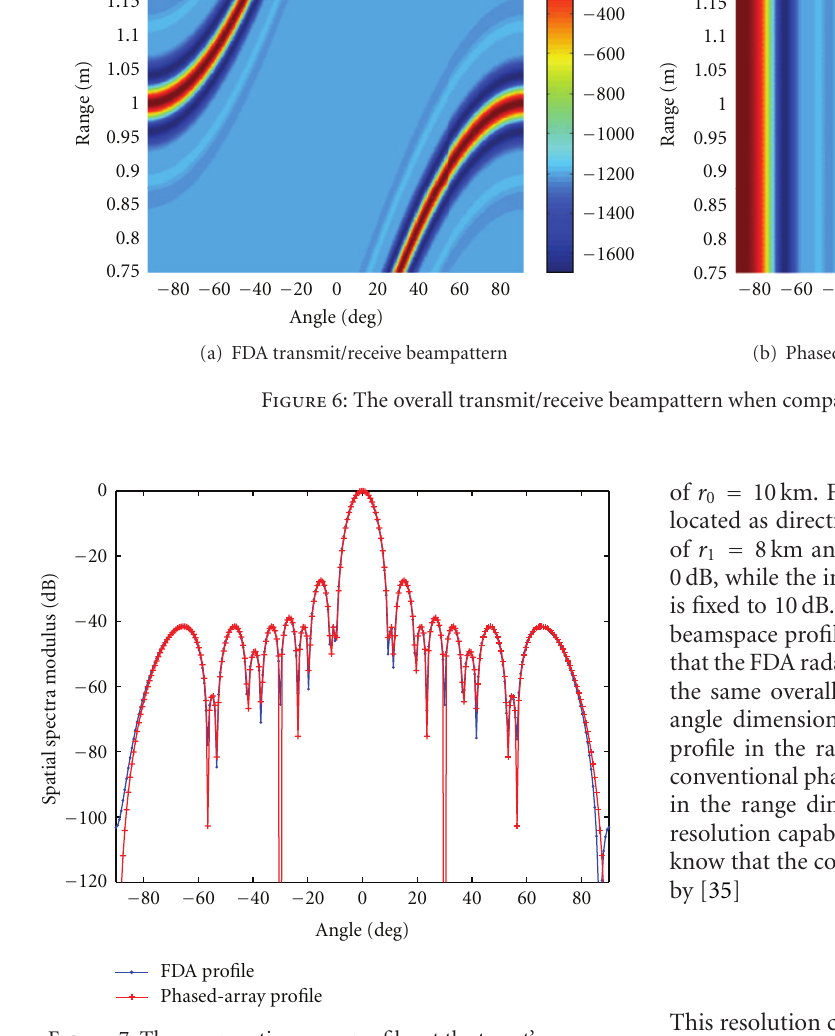
Figure 7: The comparative range profiles at the target’s